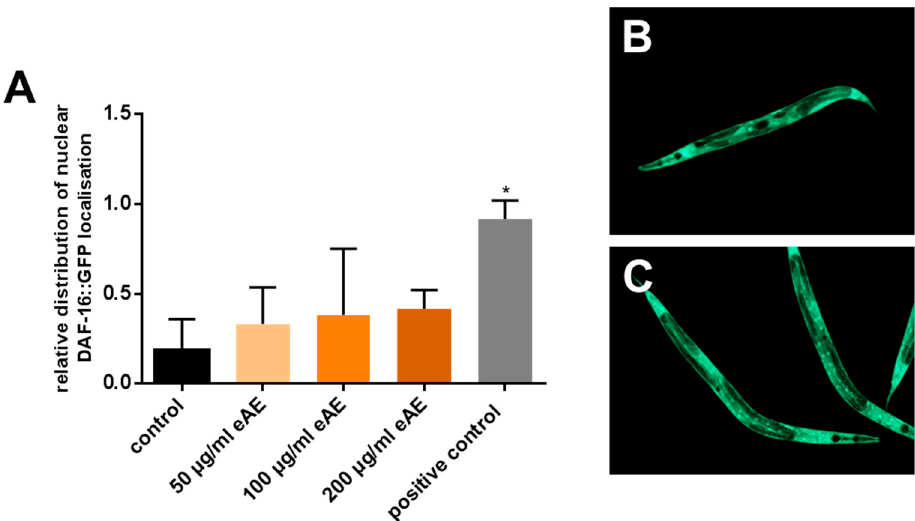
Figure 3. Effects of eAE on the intracellular localization of DAF-16. ( A ) Intracellular localization of DAF-16: L4 larvae of the transgenic strain TJ356 (DAF-16::GFP) were incubated with different concentrations of eAE or DMSO (vehicle, 0.4%) for 1 h at 20 °C or kept for five minutes at 37 °C (positive control), and localization of the transcription factor was then examined using fluorescence microscopy. Values are mean ± SD, n = 3 (each 20 individuals per group, one-way ANOVA with Tuckey’s multiple comparisons test vs. control, * p ≤ 0.05; ( B ) representative image for a nematode with mainly cytosolic localization of DAF-16; ( C ) representative image for nematodes with mainly nuclear localization of DAF-16.